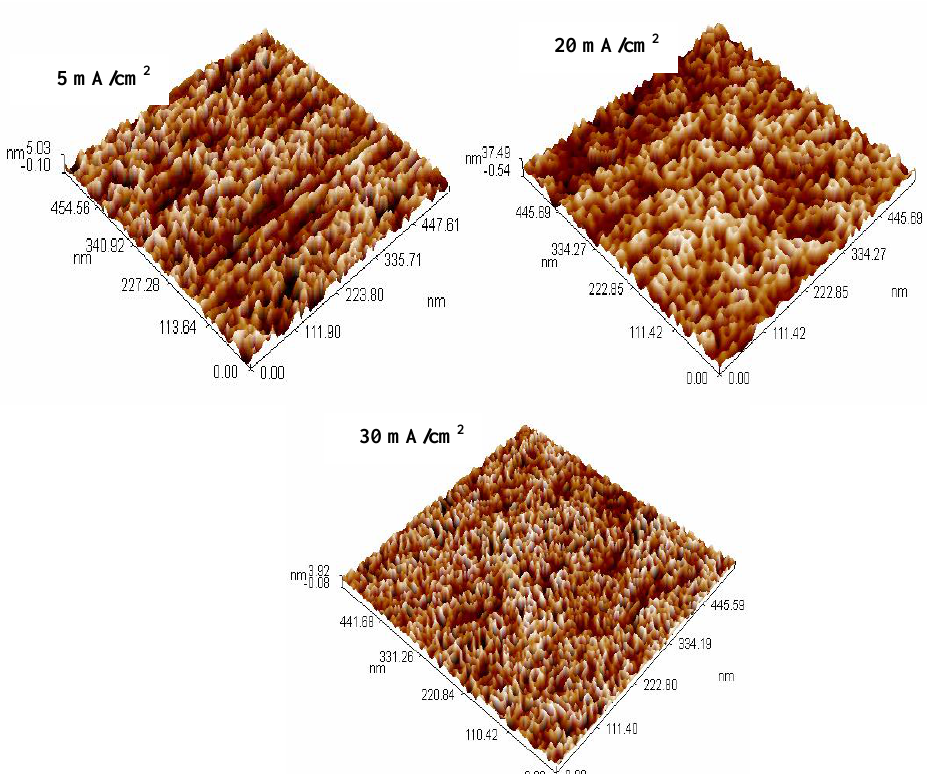
Fig.2: 3D AFM image for PS prepared under different etching current density J = 5, 20 and 30 mA/cm 2 respectively at etching time t = 15 min and HF